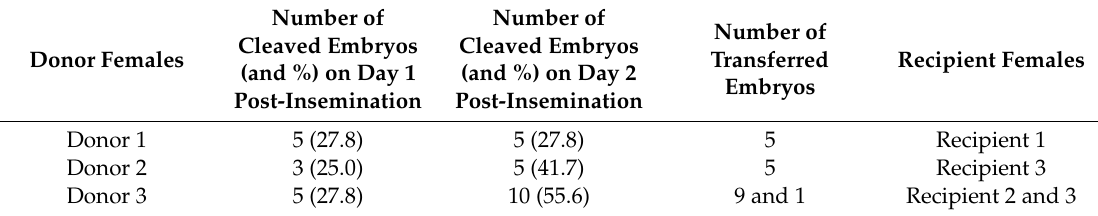
Table 4. Proportion of cleaved embryos obtained from each donor and number of embryos transferred to each recipient.